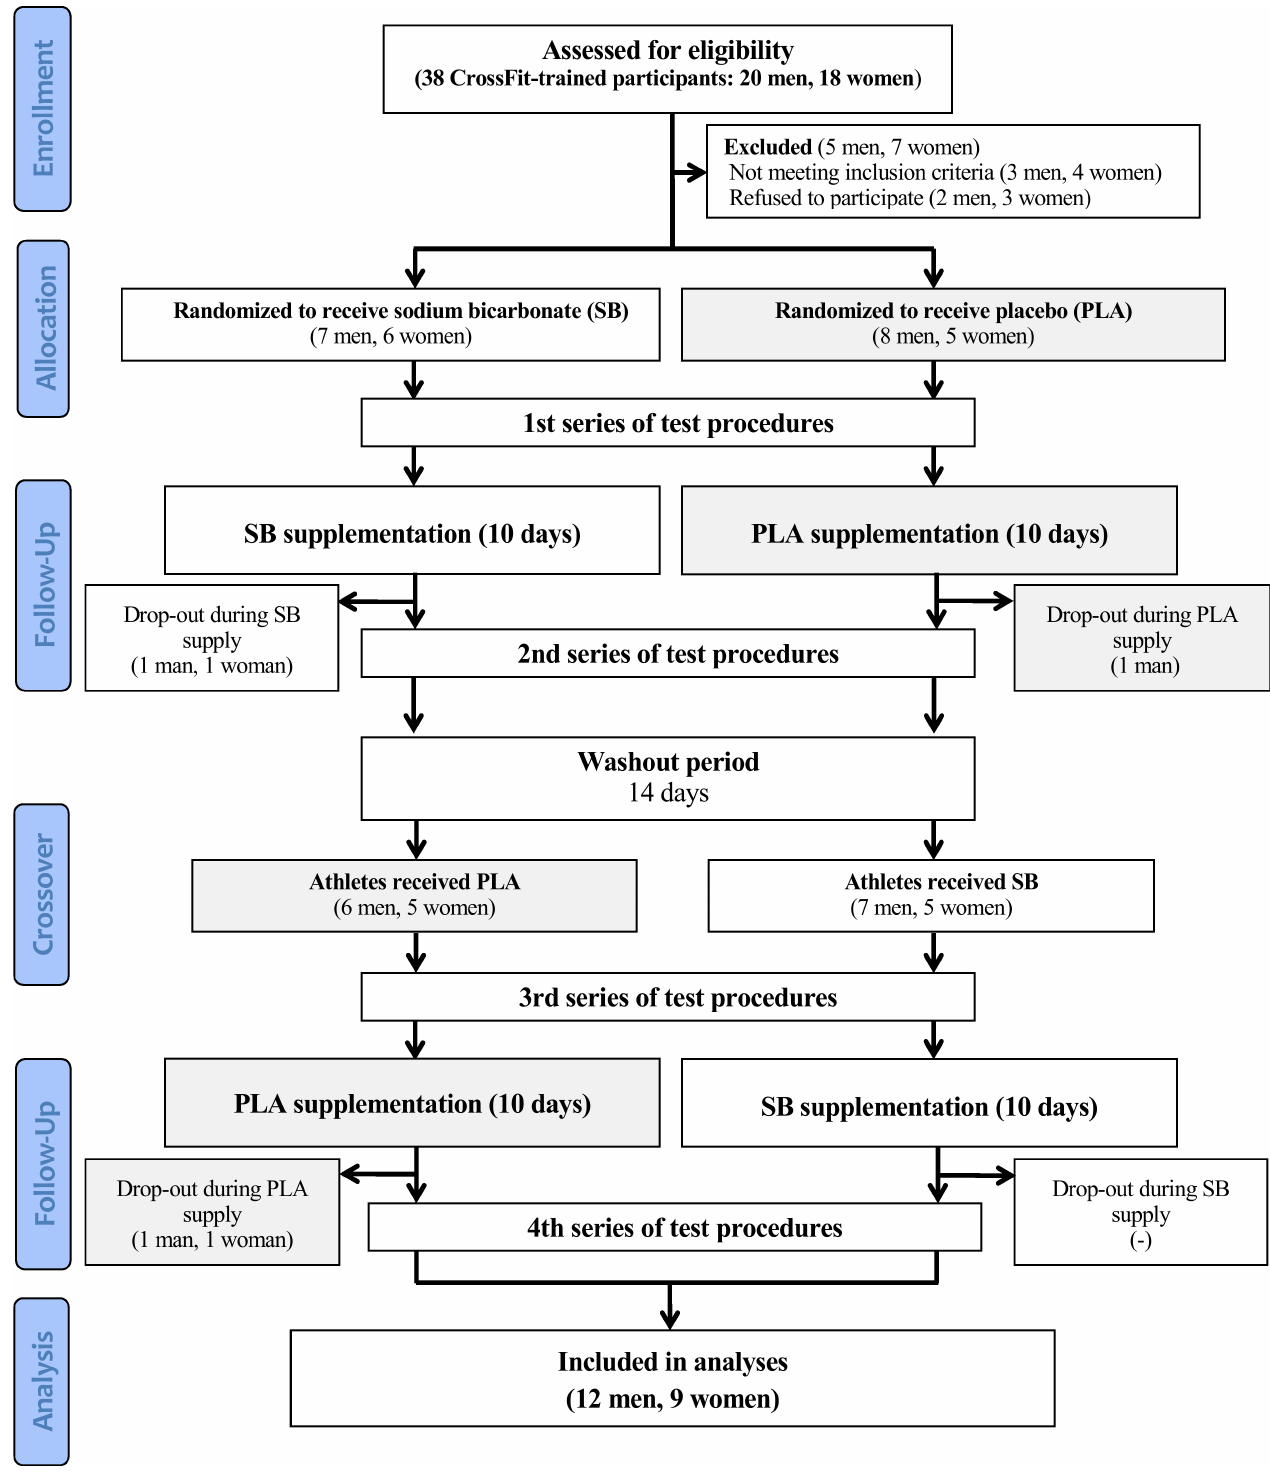
Fig 1. Flow diagram of the study design.